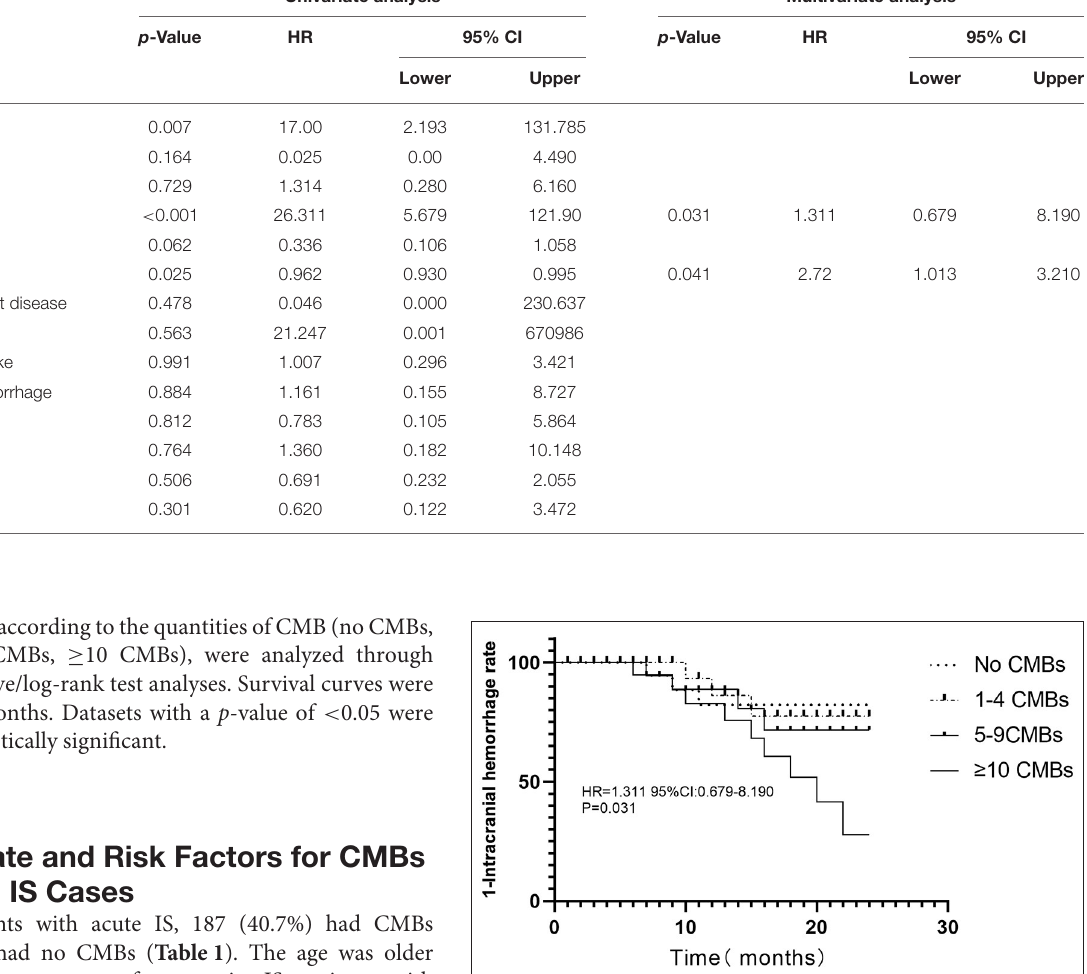
TABLE 3 | Univariate Cox regression analyses for consequent ICH and multivariate Cox regression analyses for ≥ 10 CMB events in predicting subsequent ICH (adjusted by age). Variable